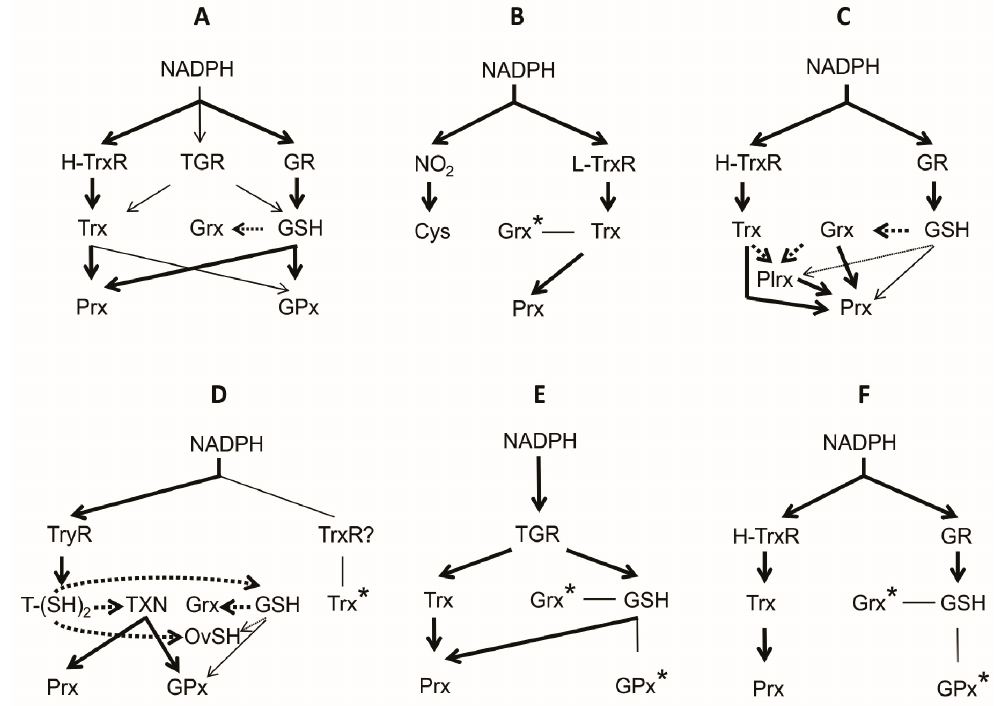
Figure 7 . Architecture of the thiol-based antioxidant systems in animals. The organization of the antioxidant redox system present in the phylum Vertebrata ( A ); and in the parasite representatives of the phyla Amoebozoa ( B ); Apicomplexa ( C ); Kinetoplastida ( D ); Platyhelminthes ( E ); and Nematoda ( F ) phyla are shown. In each case, the predominant and the minor electron flow is indicated as a continuous thick arrow and a continuous thin arrow, respectively. Potential electron transfer reactions involving only redox substrates is represented by a dark (highly favoured) or light (poorly favoured) dotted arrow. From bioinformatic analysis, the presence of some components (*) is proposed. The debatable presence of a TrxR in the representatives of Kinetoplastida is indicated by a question mark (?).